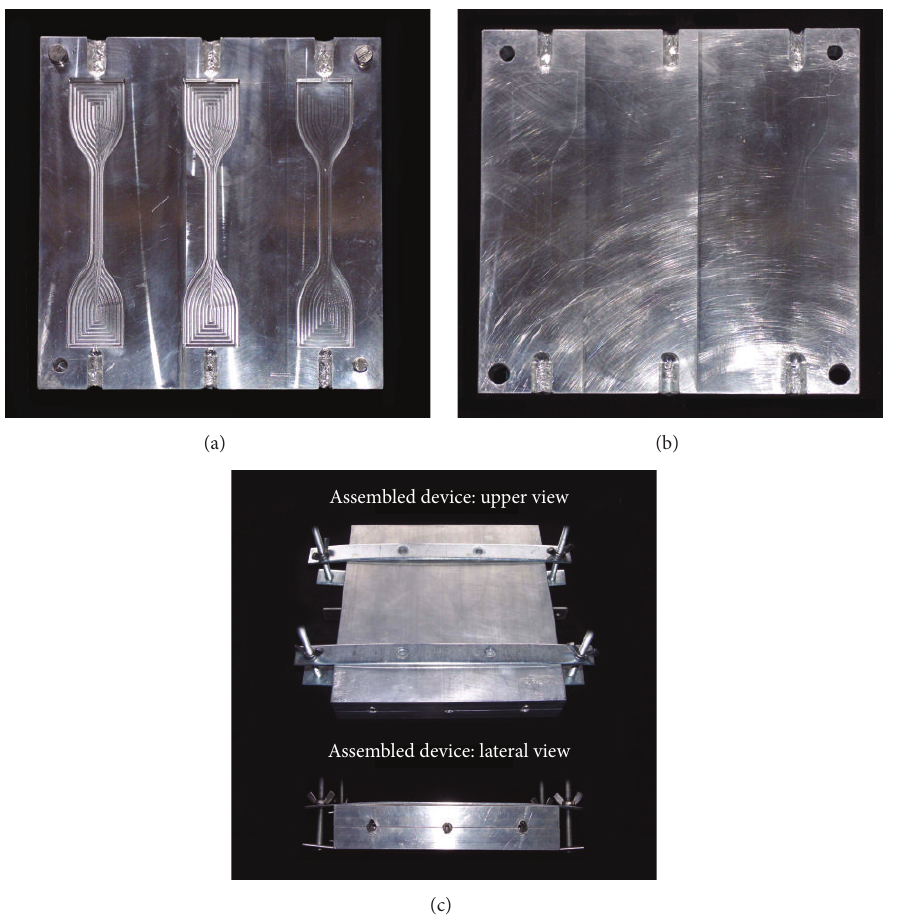
Figure 2: Stainless steel split mold used to produce the dumbbell test specimens: lower (a) and upper (b) plates. Once the mold was assembled (c), paths for the injection of the impression materials through lateral apertures were made available.